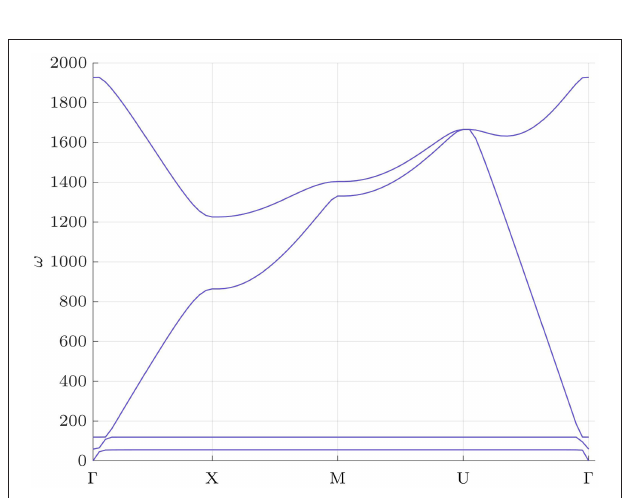
FIGURE 11 | Dispersion diagram for a periodic array (pitch d spherical rigid shells (radius of spheres from inner to outer are 0.1, 0.15, 0.3, and 0.4 m) with one thin channel in each shell (respectively of lengths 0.05 and 0.1 m and radii 0.005 and 0.01 m) representing the frequency ω (rad.s − 1 ) of pressure waves in air vs. the wavenumber k Bloch vector k along the edges of the irreducible Ŵ XMU . We note the appearance of two frequency stop bands for ω and ω [118.9750,119.0959] rad.s − 1 ∈